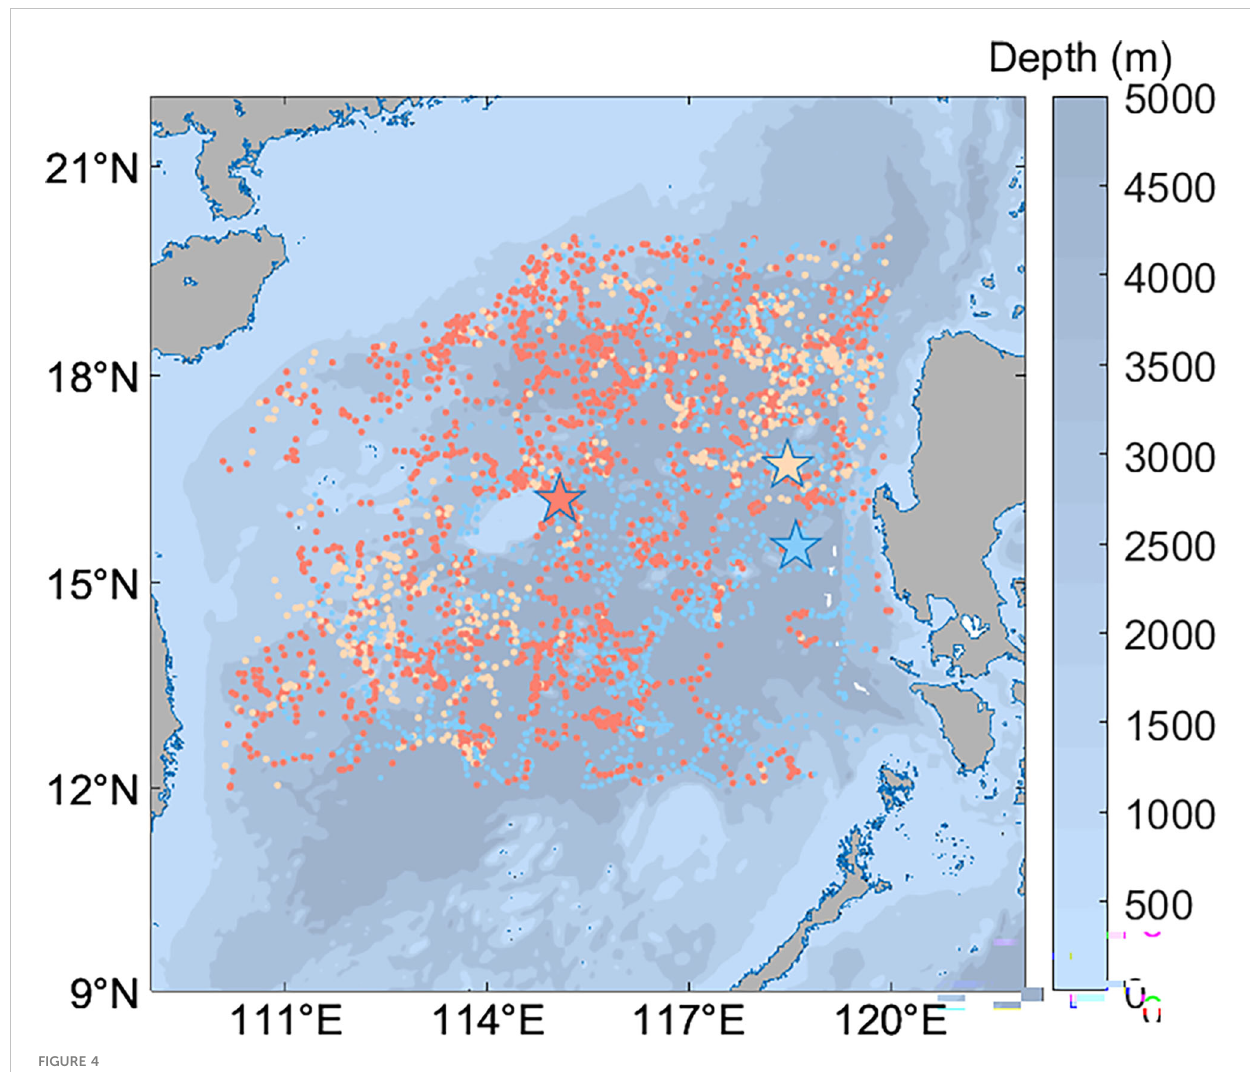
FIGURE 4 Distribution of samples after classi fi cation, asterisks mark class